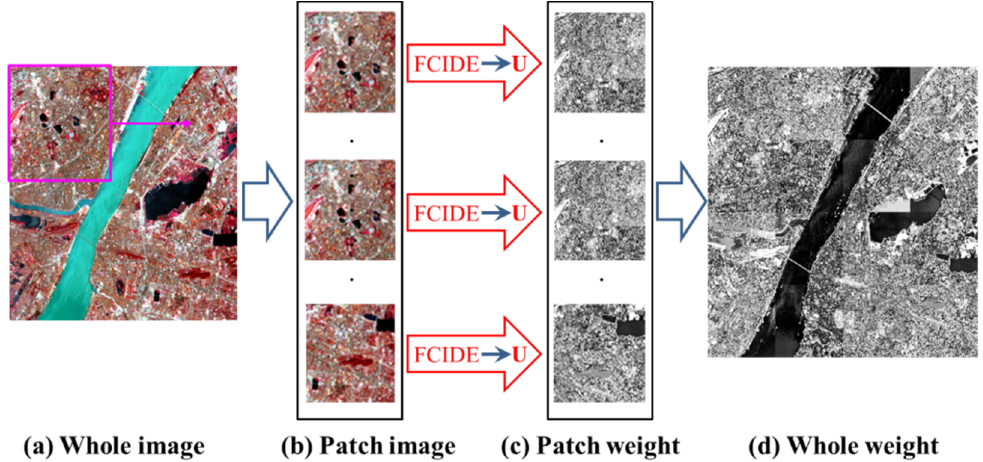
Figure 5. The flowchart of FCIDE-based local weight parameter determination method. ( a ) Whole image; ( b ) Patch image; ( c ) Parch weight; and ( d ) Whole weight.